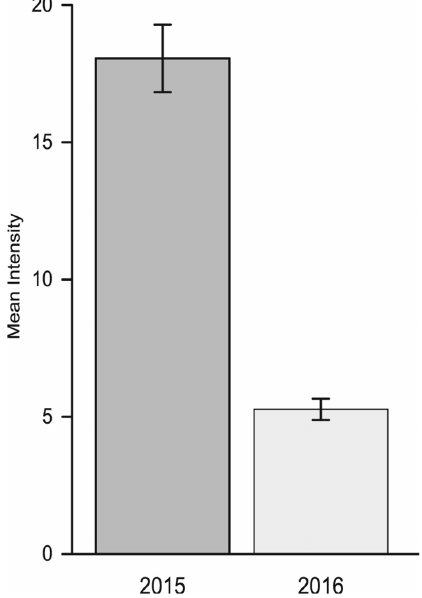
Figure 1. Mean intensities by year in Zaedyus pichiy from Mendoza, Argentina.